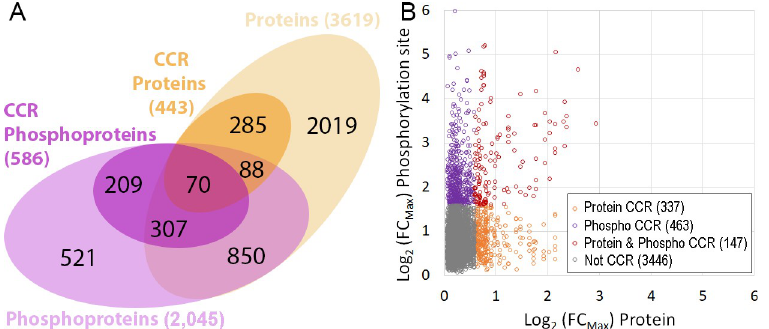
Fig 3. Comparison of cell cycle regulated phosphorylation sites and proteins. A. Venn diagram of overlap at the protein level (proteins and phosphoproteins). B. Scatter plot of overlap at the phosphorylation site level (proteins versus phosphorylation sites); Grey, not CCR; Purple, phosphorylation site CCR; Orange, protein CCR; Red, protein and phosphorylation site CCR.